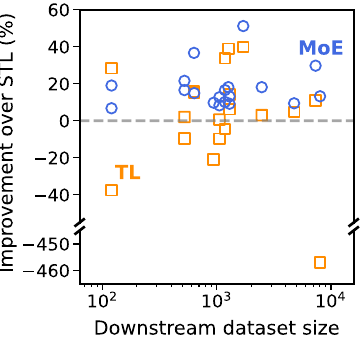
Fig. 3 Benchmarking transfer learning and mixture of experts performance versus dataset size. Percent improvement on MAE across 19 materials property regression tasks of transfer learning from Materials Project formation energies (TL) and our mixture of experts approach (MoE) over single-task learning with random initialization (STL). For clarity, the y axis above and below the break have different scales. Examples of positive and negative transfer are indicated by points above and below the gray dotted line,